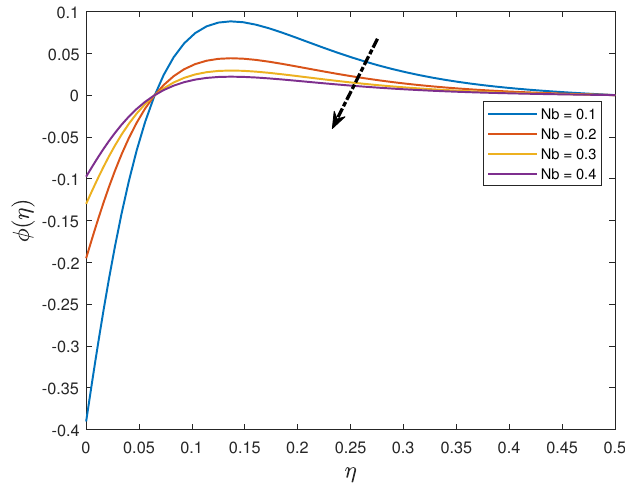
Figure 14. Influence of Nb on the nanofluid